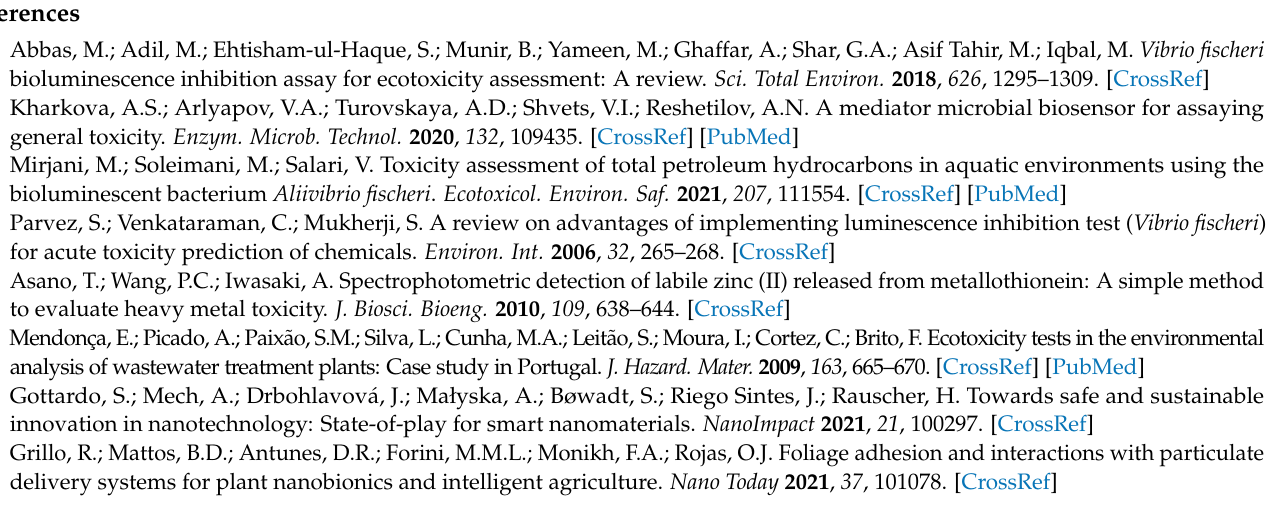
SEM images illustrating morphological changes throughout the life cycle of a V. fischeri population, Figure S4: SEM image of V. fischeri in the stationary phase (53 h timepoint), Figure S5: SEM image